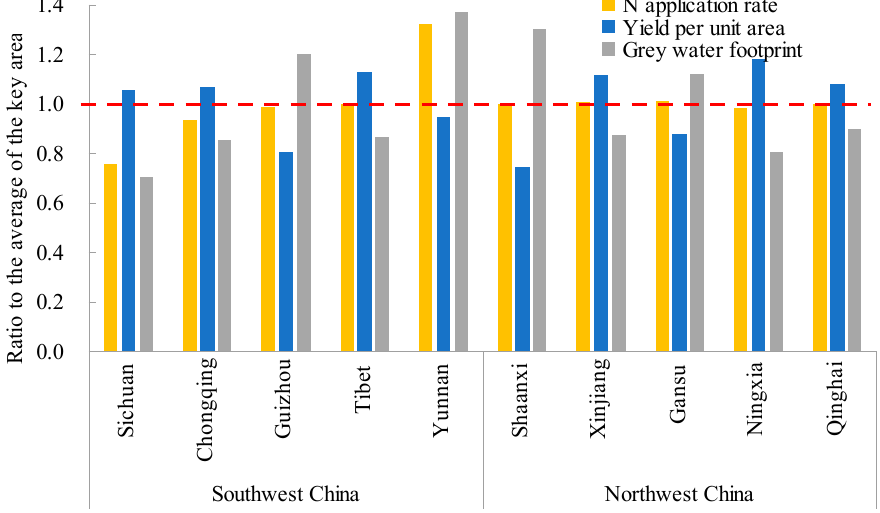
Figure 8. The fold-change of the ratio of factors affecting WF grey for maize production to the divisional average in provinces of Southwest China and Northwest China.